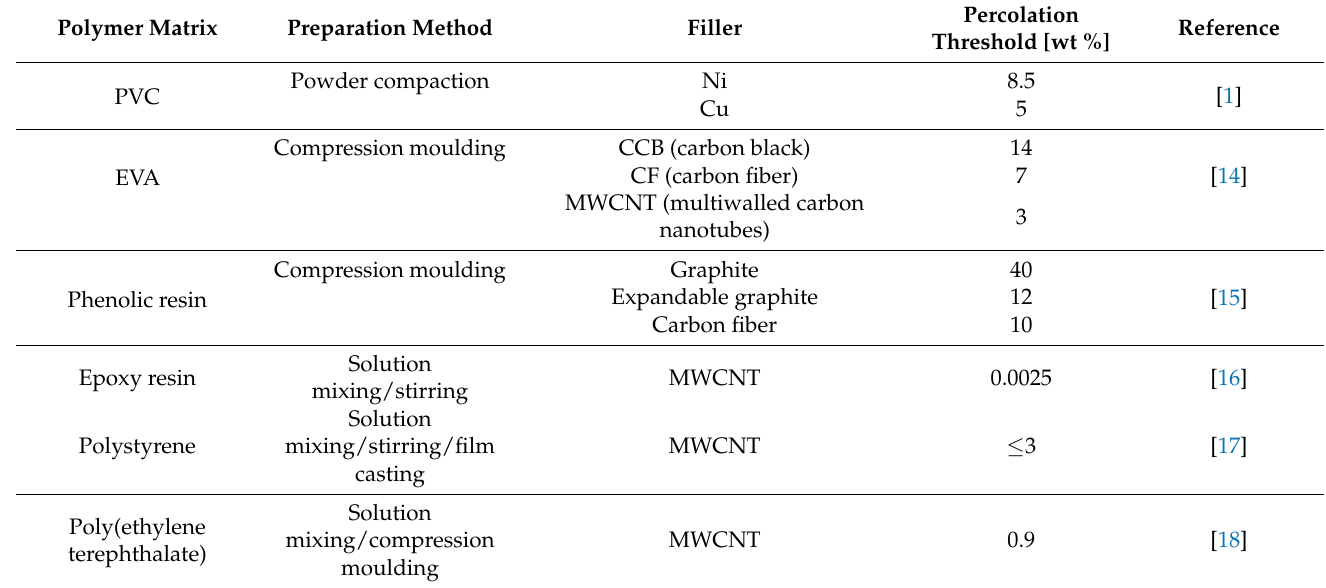
Table 1. Percolation threshold of electrically conductive polymer